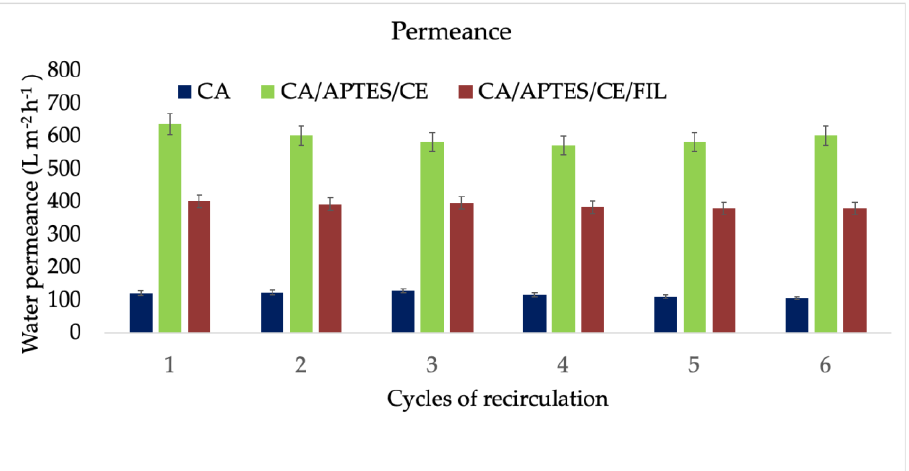
Figure 6. Permeance after 5 recirculation cycles. The errors were calculated using 5 membranes to evaluate the homogeneity of the materials obtained.